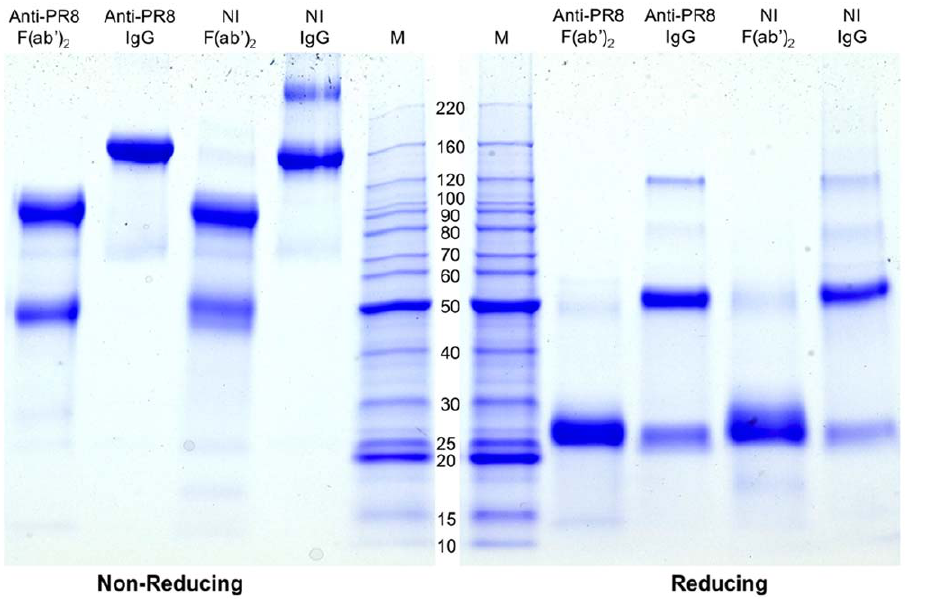
Figure 1. SDS-PAGE of IgG and F(ab’) 2 preparations. Protein samples in SDS buffer were subjected to electrophoresis under non-reducing and reducing conditions through a 4–20% Tris-HEPES SDS-PAGE gel. The gel was stained with Coomassie blue G-250. Molecular mass markers (M) are indicated in kilodaltons. NI, non-immune. The minor band in the non-immune IgG preparation run under non-reducing conditions corresponds to IgG dimers which can sometimes form after freeze-drying. The results are typical of profiles from three separate SDS-PAGE analyses of these particular preparations and of many other analyses of colostrum-derived antibodies .